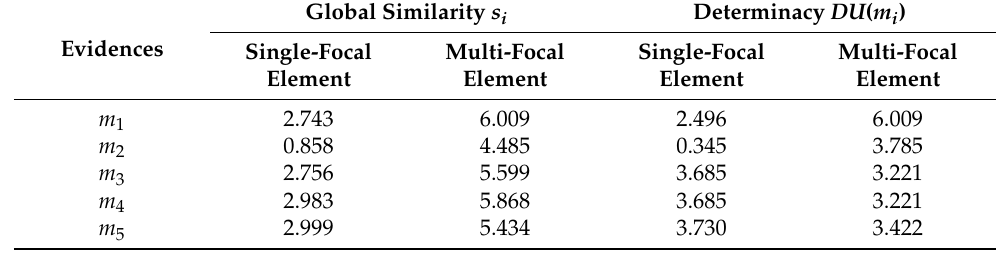
Table 7. Similarity and certainty of evidence under single and multifocal elements.